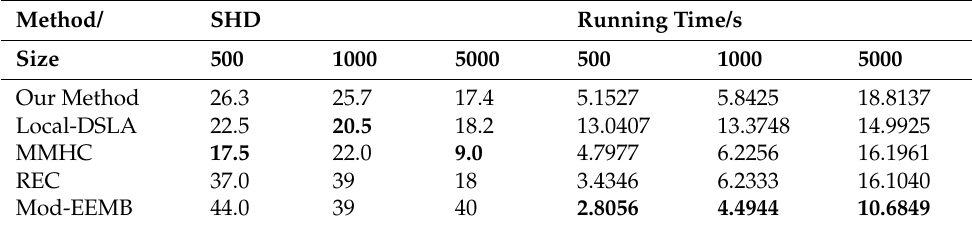
Table 2. Results for data Child3.